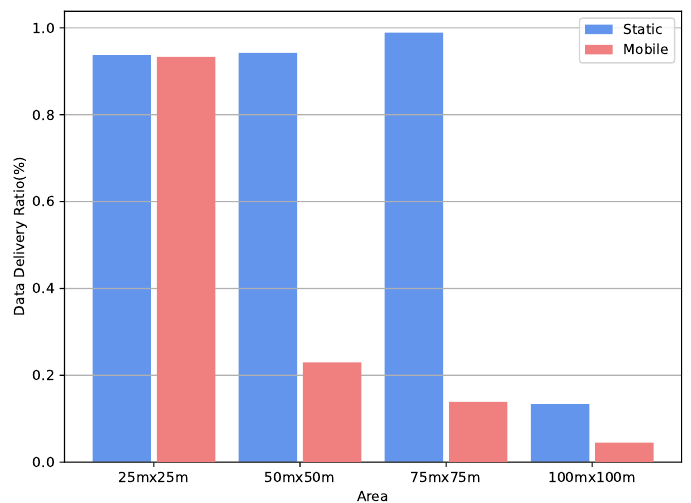
Figure 6. Data delivery ratio for trees vs.